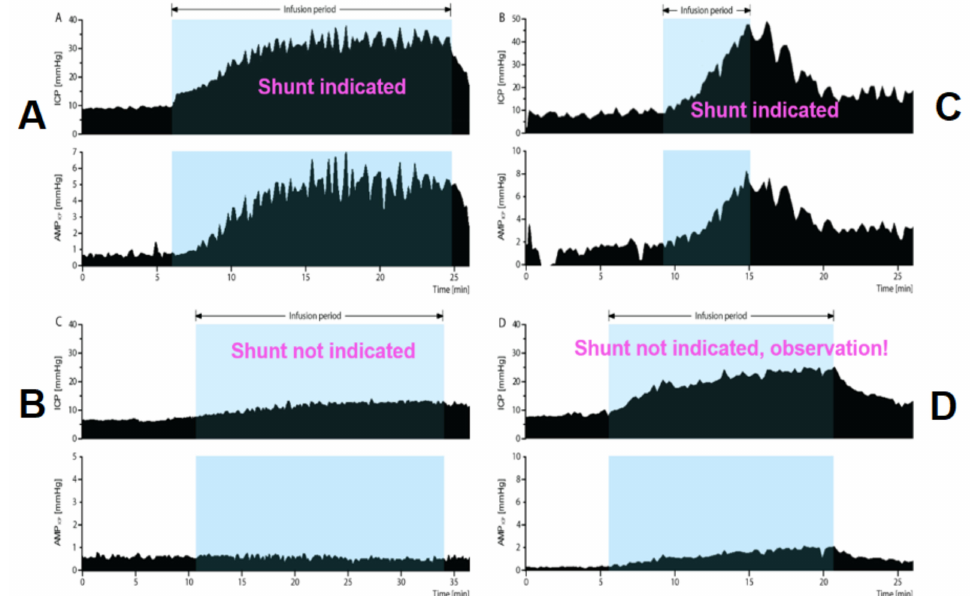
Figure 13. Who requires shunt from a CSF dynamics perspective? ( A ): increased resistance to CSF outflow, frequent and prominent slow waves of ICP (b-waves) are considered indicators of significant disturbance of CSF dynamics and such patterns have not been described in physiological individuals. ( B ): very low Resistance to CSF outflow, dampened and unresponsive amplitude of ICP (AMP), indicating that shunting will most likely not alter the CSF circulation impactfully and that the amount of atrophy and/or lack of cerebrovascular bed reactivity signify irreversible changes. ( C ): Acute and steep rise of ICP after infusion of minimal volume, signifying severe disturbance of CSF circulation, with ICP rising > 40 mmHg despite seemingly “normal” baseline pressure. ( D ): normal/borderline CSF dynamics, clinical monitoring might be the best choice until clearer disturbances arise. (Figure modified from M.Czosnyka, 30 Lectures on Brain Physics, https://www.neurosurg.cam.ac.uk/research-groups/brain-physics-lab/brain-physics-lectures-20 20/?fbclid=IwAR0A6Yh-NqAheMO7GHi2HHD-Bug5mgSyhK7nWM1uG729wbt4a6XNqOzFZQ4, accessed on 13 April